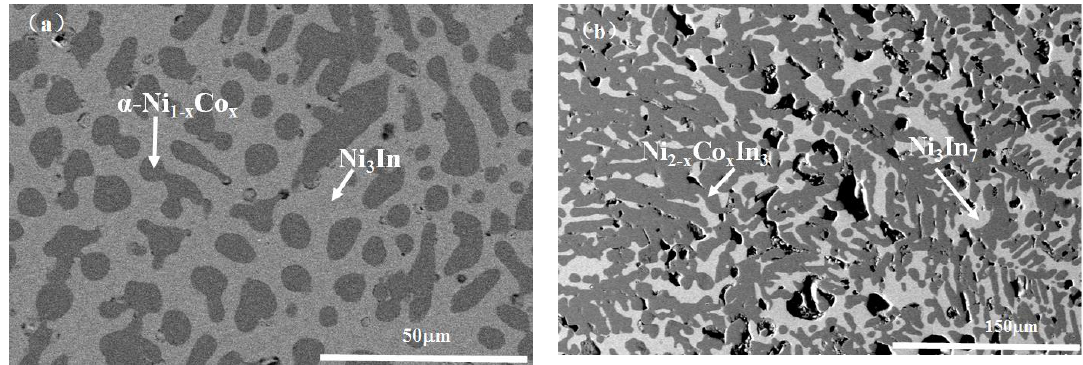
Figure 1. BSE micrograph of ( a ) No. 1 (Co10Ni75In15) and ( b ) No. 2 (Co4Ni34In62).